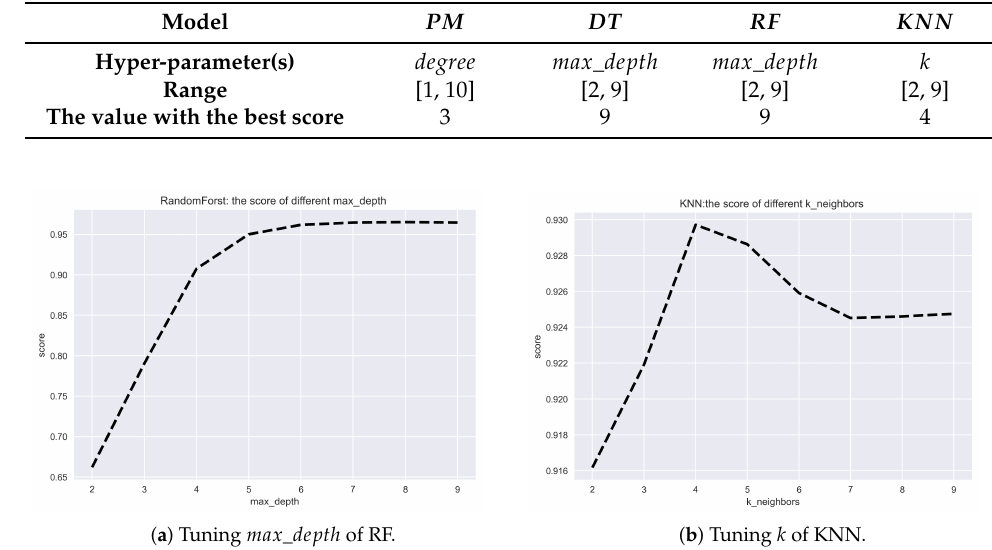
Figure 6. Hyper-parameters tuning.